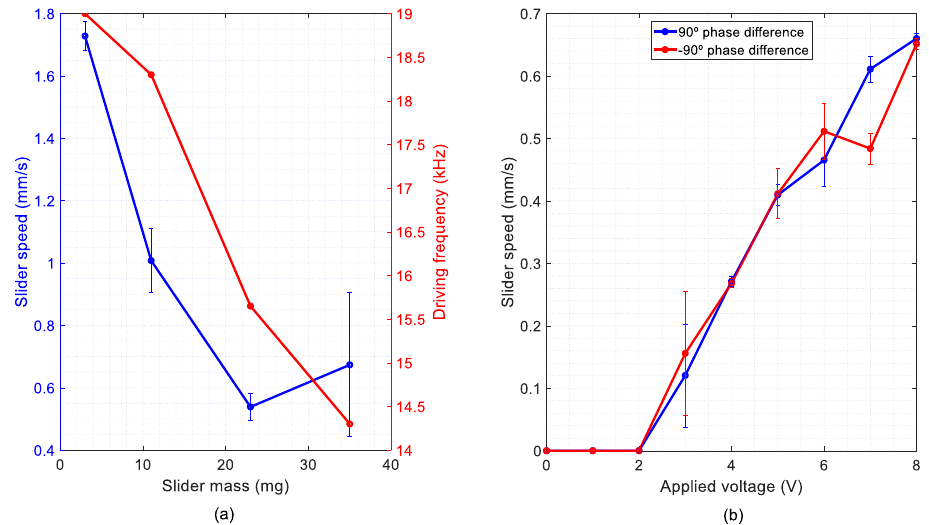
Figure 9. Results from the kinetic characterization of the LF device: ( a ) average speed of the sliders versus their mass for a voltage amplitude of 6 V and ( b ) average speed of the 23 mg slider at different excitation amplitudes.